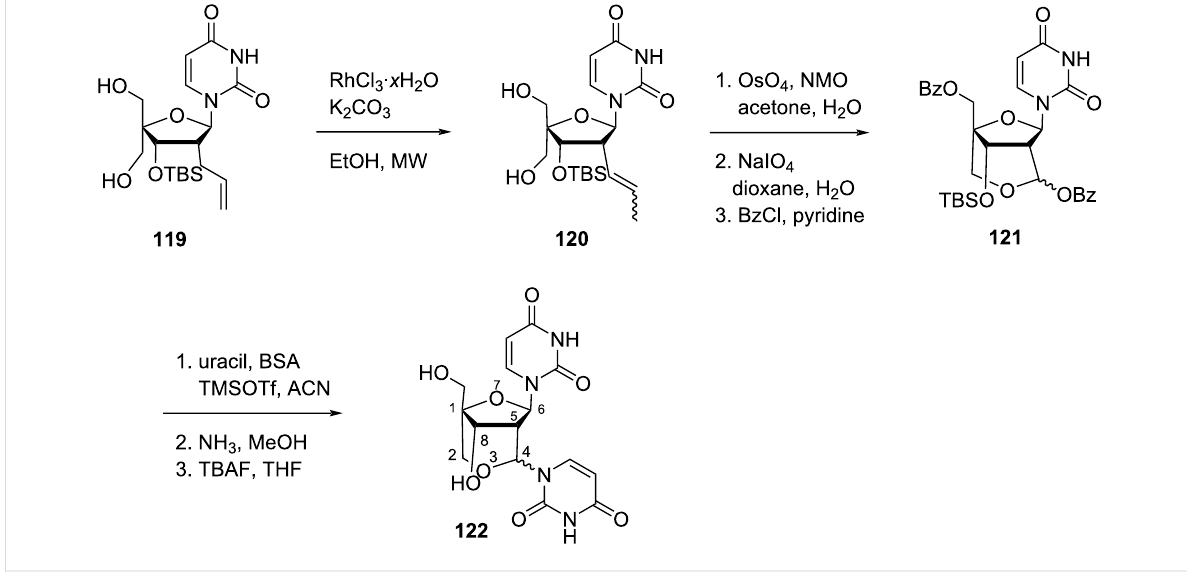
Scheme 29: Synthesis of bicyclic double-headed nucleoside 122